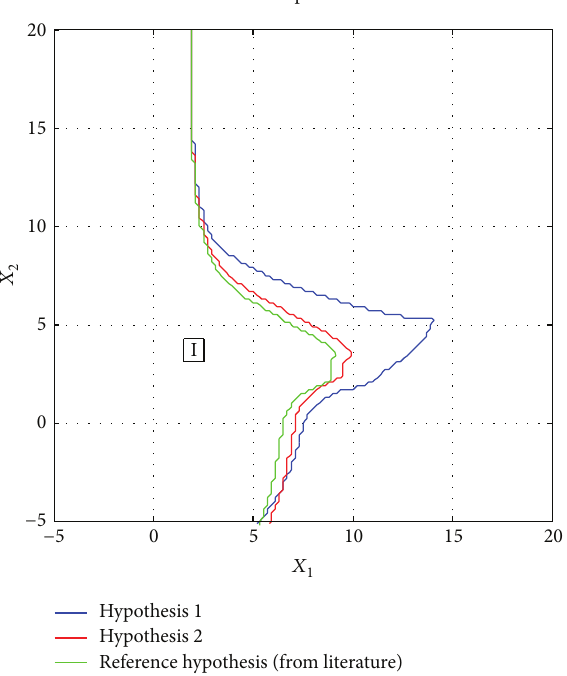
Figure 3: Production policy for 𝑃 1